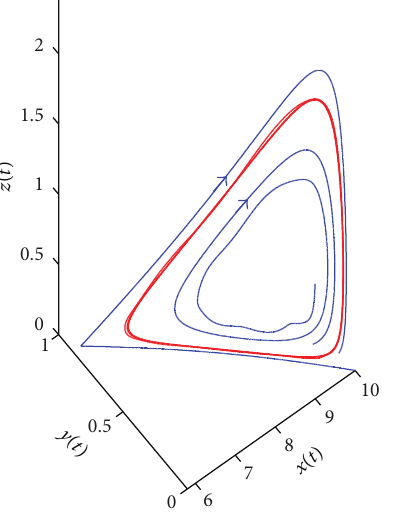
Figure 3: The bifurcating periodic solution from the equilibrium 𝐸 2 of system (3) occurs when 𝜏 = 5